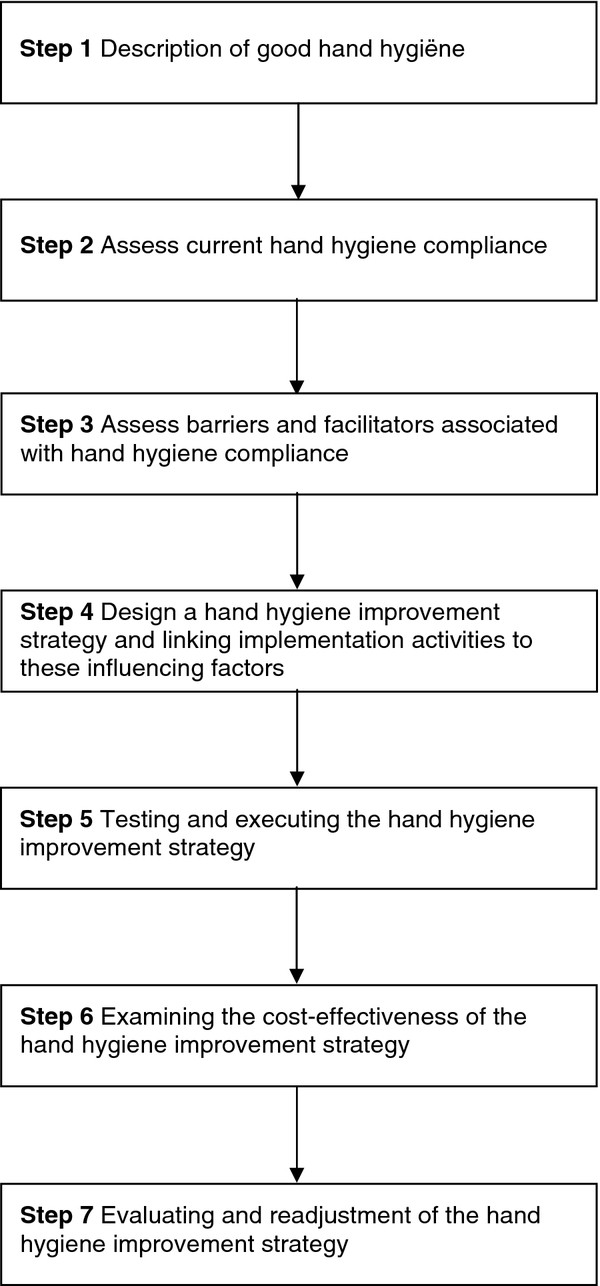
Building a successful hand hygiene improvement strategy.